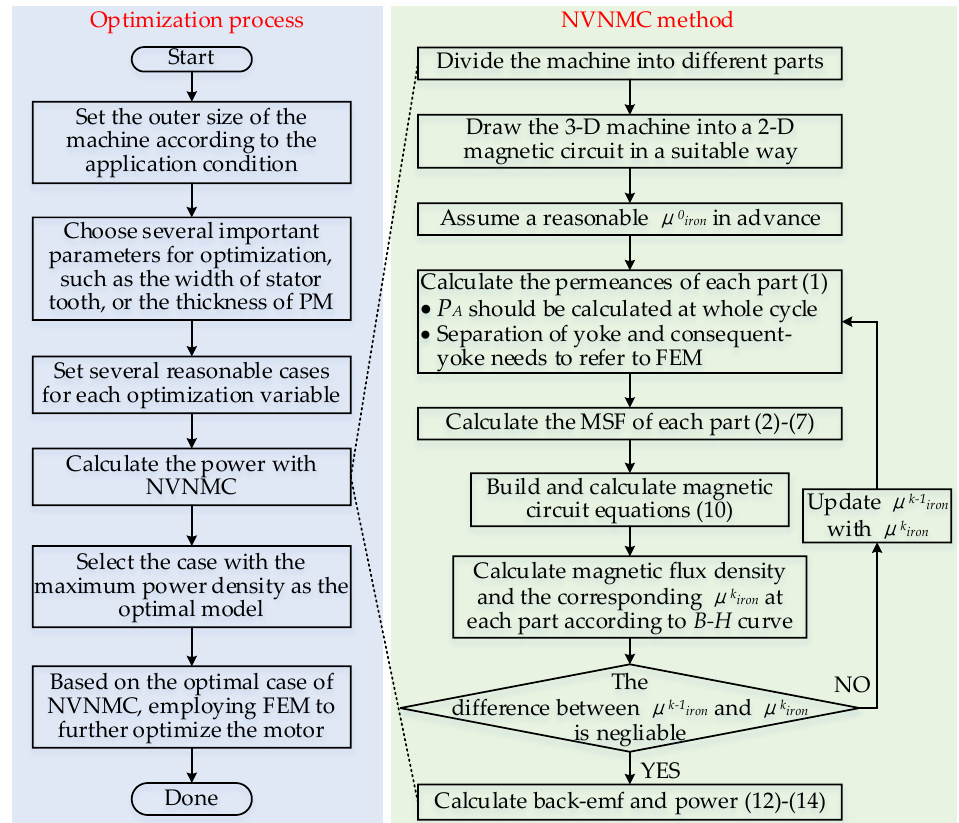
Figure 13. Flowchart of optimization.